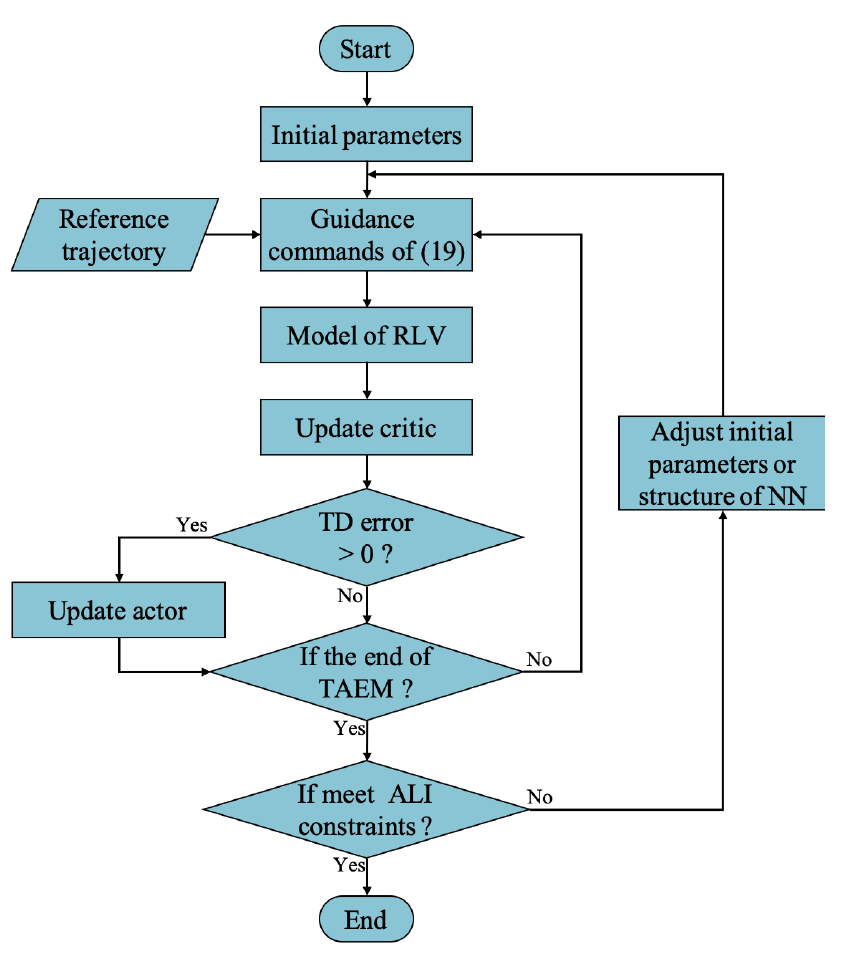
Figure 1. The flowchart of the off-line training of CACLA.